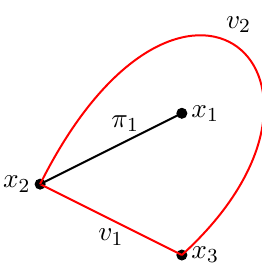
Figure 6 . Ramification points away from infinity of the generic fiber. The black line denotes the choice of a branch cut, v